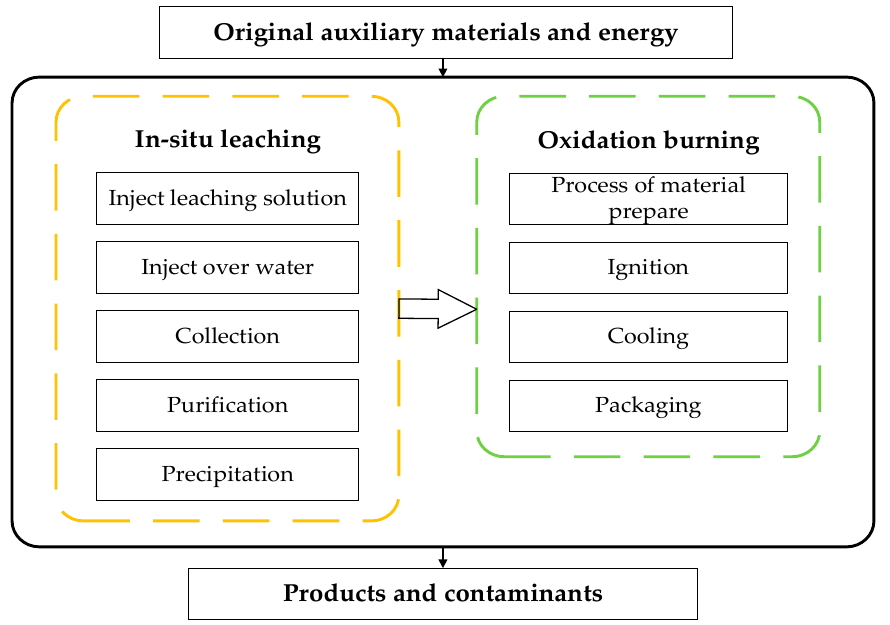
Figure 1. System boundary.